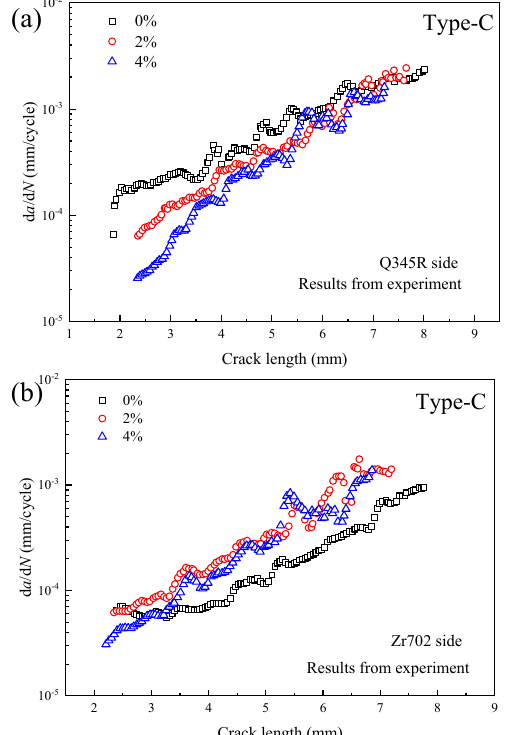
sides of the material is different, so comparing the effect of the pre-strain level on each